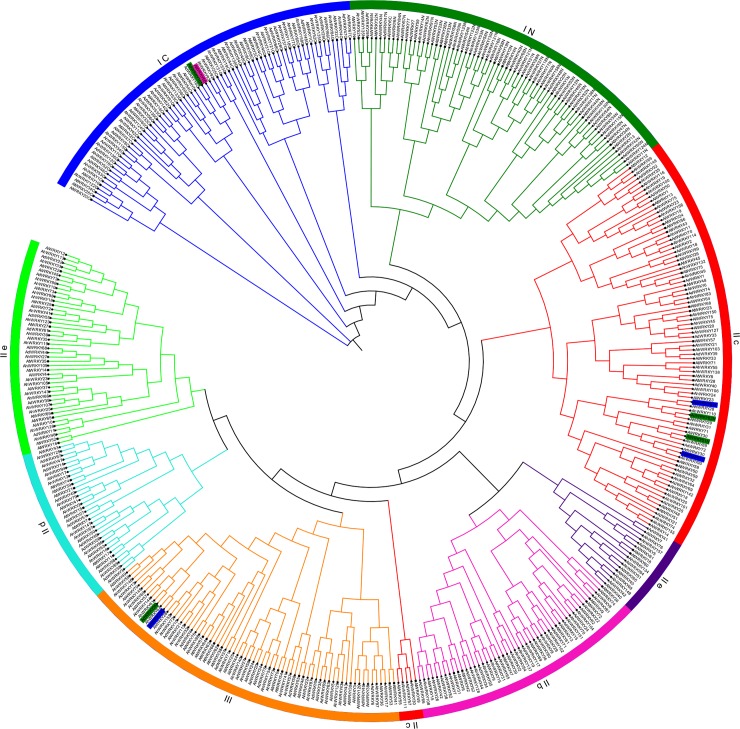
Phylogenetic tree of WRKYs among Arachis hypogaea, Arabidopsis thaliana, Arachis duranensis and Arachis ipaensis.The groups (I, II and III) and subgroups (IIa, b, c, d and e) were distinguished in different colors, and the different species were marked by different symbols. Stars represented WRKY genes from Arachis hypogaea, and squares indicated genes from Arabidopsis thaliana. Circles and right triangles indicated WRKY genes from Arachis ipaensis and Arachis duranensis, respectively.